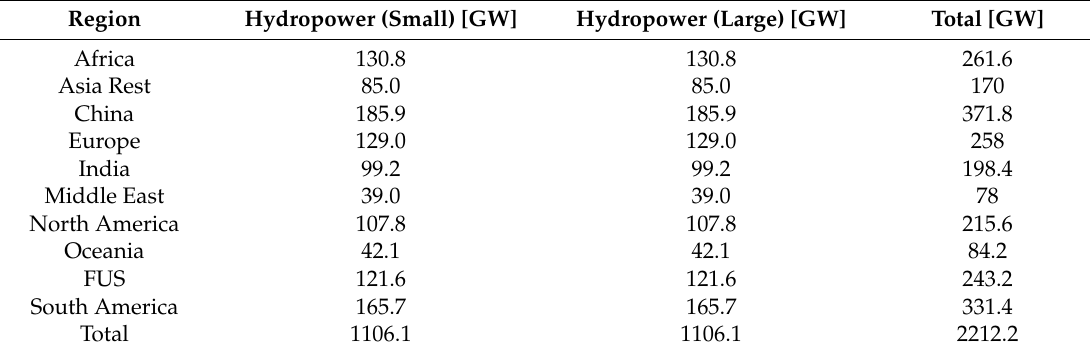
Table 6. Hydropower—Regional and Economical